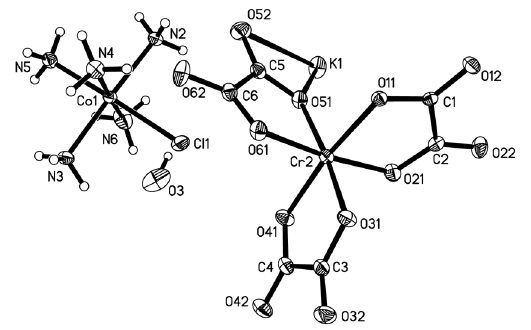
Figure 1. Asymmetric part of the structure of 1 with the atom numbering scheme. Thermal ellipsoids are plotted at 30% probability